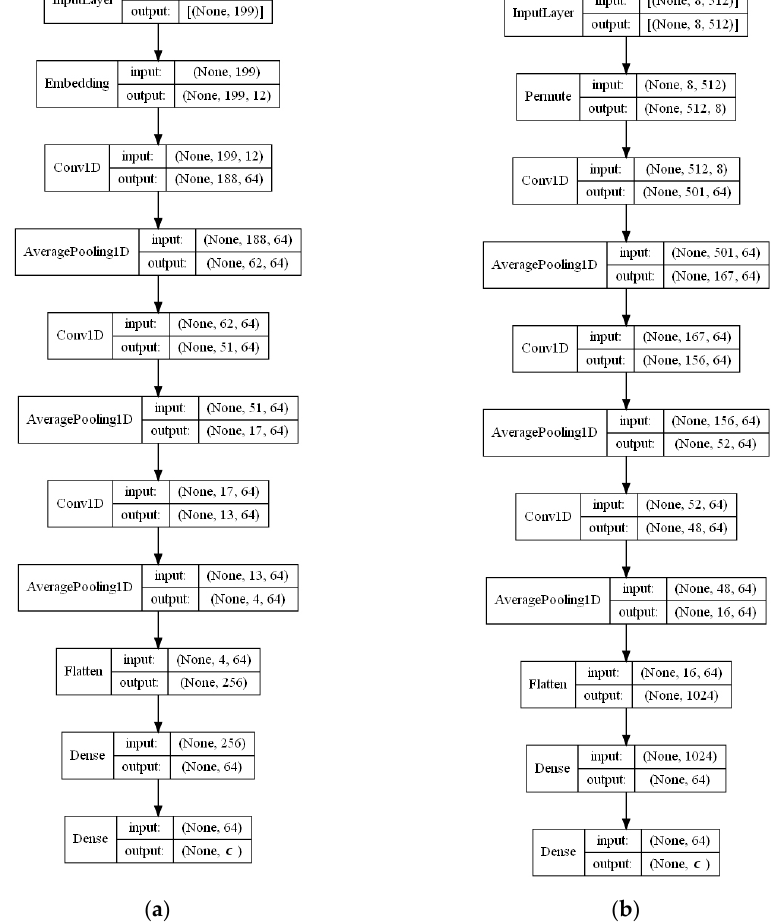
Figure A6. The 1D CNN neural network topology. Used with LE vectorization ( a ), with ECFP vectorization ( b ).